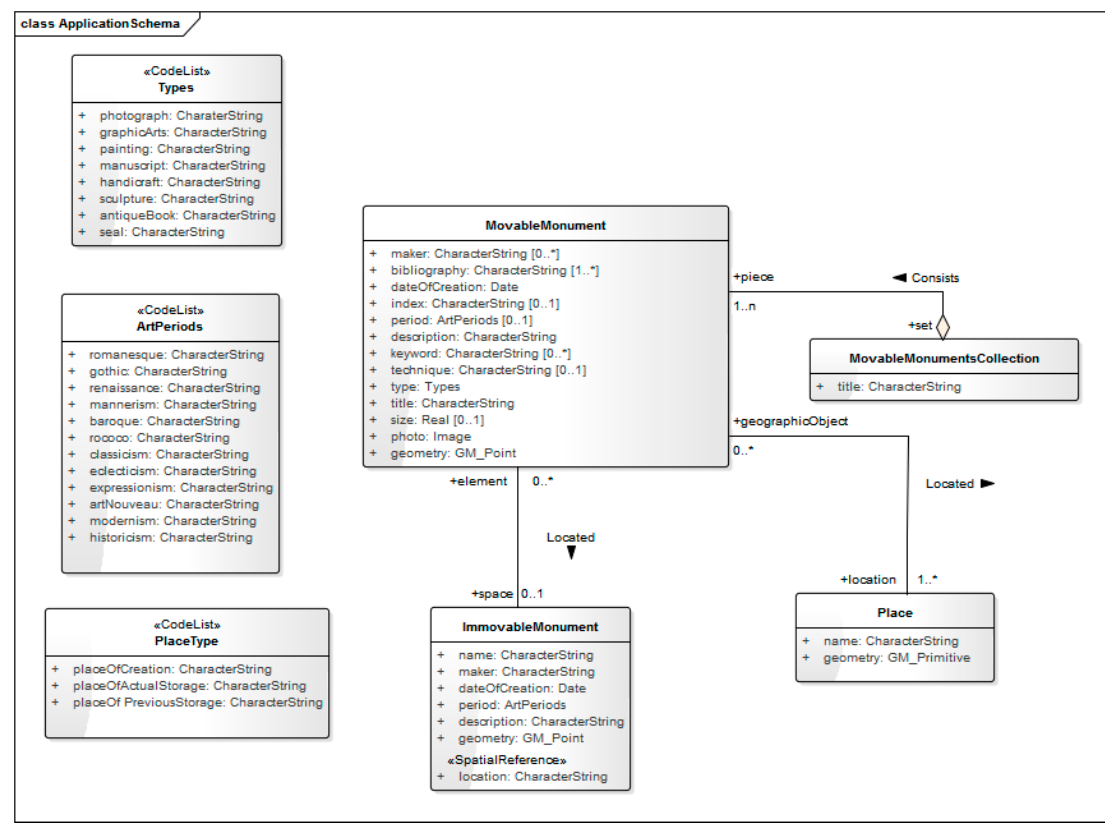
Figure 10. An Unified Modeling Language (UML) class diagram describing the concept of spatial database structure for movable monuments (source: own work).